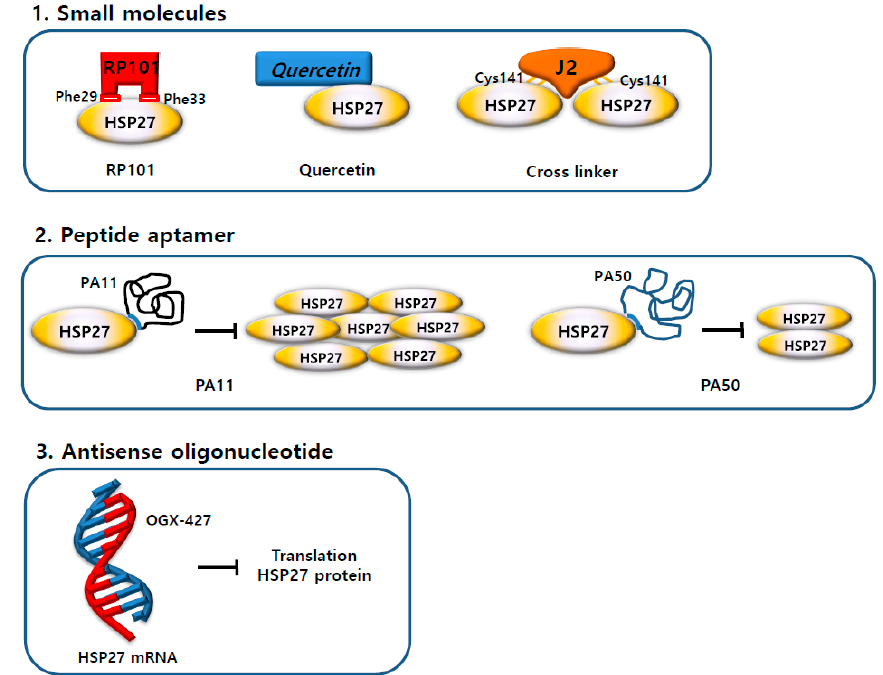
Figure 6. Strategies of heat shock protein 27 (HSP27) inhibitors. ( 1 ) Three small molecule inhibitors (Brivudine (RP101), Quercetin, and cross-linker) bind directly to the HSP27 protein and inhibit the activity of the HSP27 protein. ( 2 ) Peptide aptamers (PA11 and PA50) bind directly to the HSP27 protein and inhibit oligomerization or dimerization. ( 3 ) Antisense oligonucleotide (OGX-427) binds to HSP27 mRNA and prevents translation of the HSP27 protein. As a result, the amount of HSP27 protein is reduced.